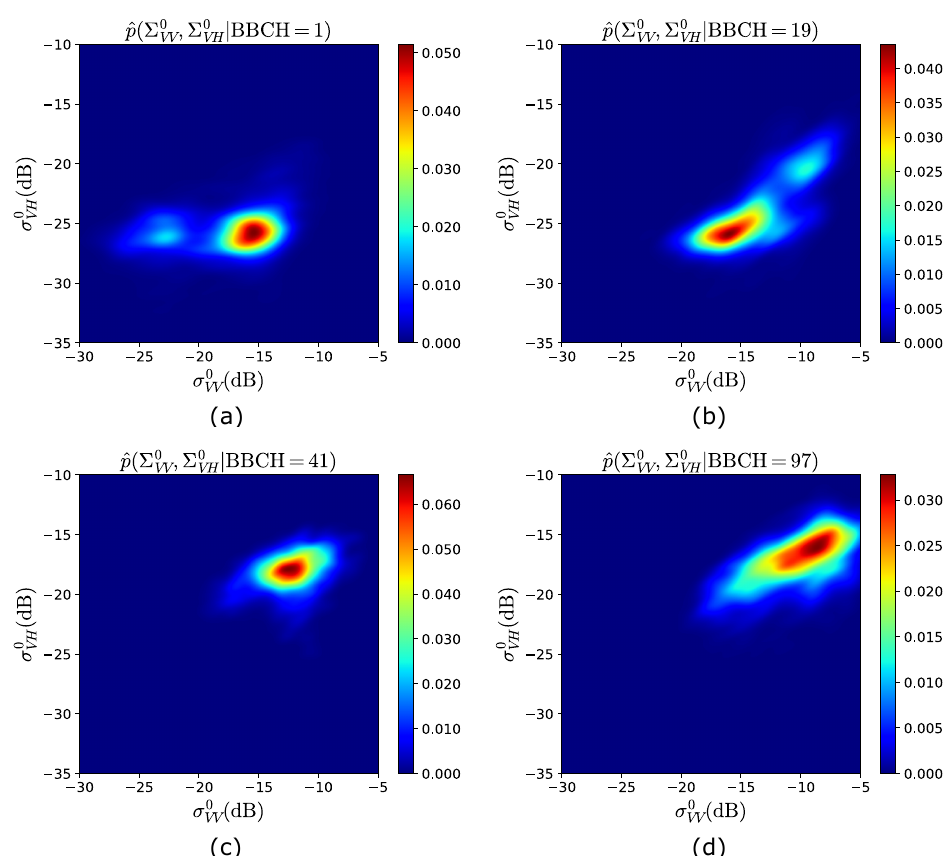
Figure 3. Observation model obtained from the training years 2017–2019. 2D view